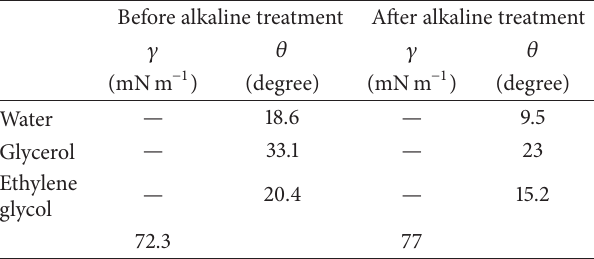
Table 3: Estimation of the surface tension of the treated and the nontreated Na-mordenite plates from the contact angles obtained with water, ethylene glycol, and